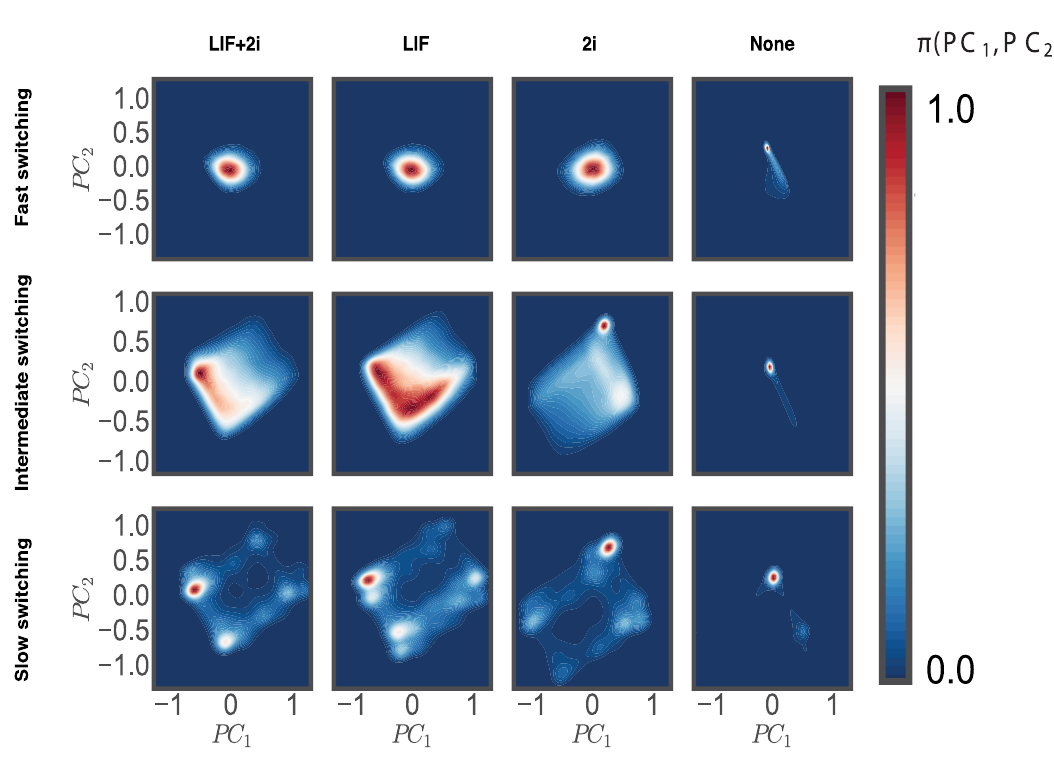
Fig 7. Mapping the cellular attractors of the genetic network under different switching and signaling conditions. We project PDMP-simulated gene expression distributions onto the first two principal components. The reference state for principal components was chosen to be the LIF+2i/intermediate